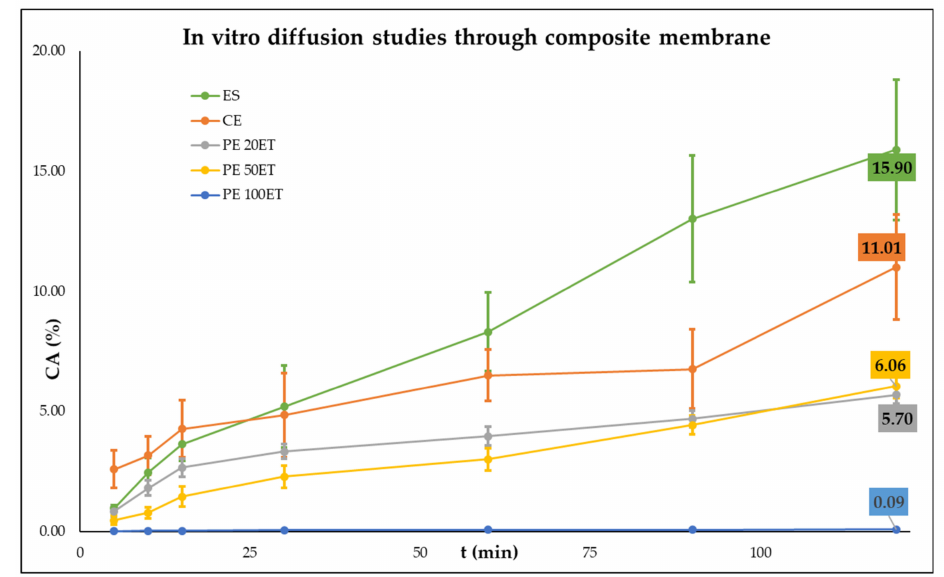
Figure 3. In vitro diffusion studies through the composite membrane. ES: ethanolic solution, CE: conventional emulsion, PE: Pickering emulsion, CA: cumulative TIO amount after 2 h. C TIO = 3.58 mg /